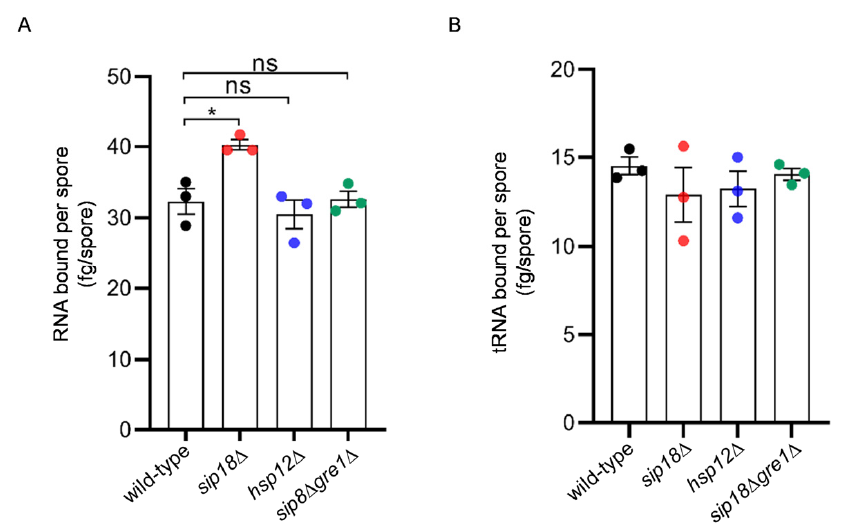
Figure 4. Analysis of the ability of hydrophilin mutant spores to hold RNA. ( A ) Amount of RNA eluted from 2 × 10 8 wild-type, sip18 ∆ , sip18 ∆ gre1 ∆ , or hsp12 ∆ spores. ( B ) Amounts of tRNA bound to high-salt-washed wild-type sip18 ∆ , sip18 ∆ gre1 ∆ or hsp12 ∆ spores. A total of 2 × 10 8 spores were incubated with 40 µ g of tRNA. Data are presented as the mean ± SEM. Statistical significance was determined by two-tailed unpaired Student’s t -tests. n = 3. *, p < 0.05; ns, not significant ( p ≥ 0.05).